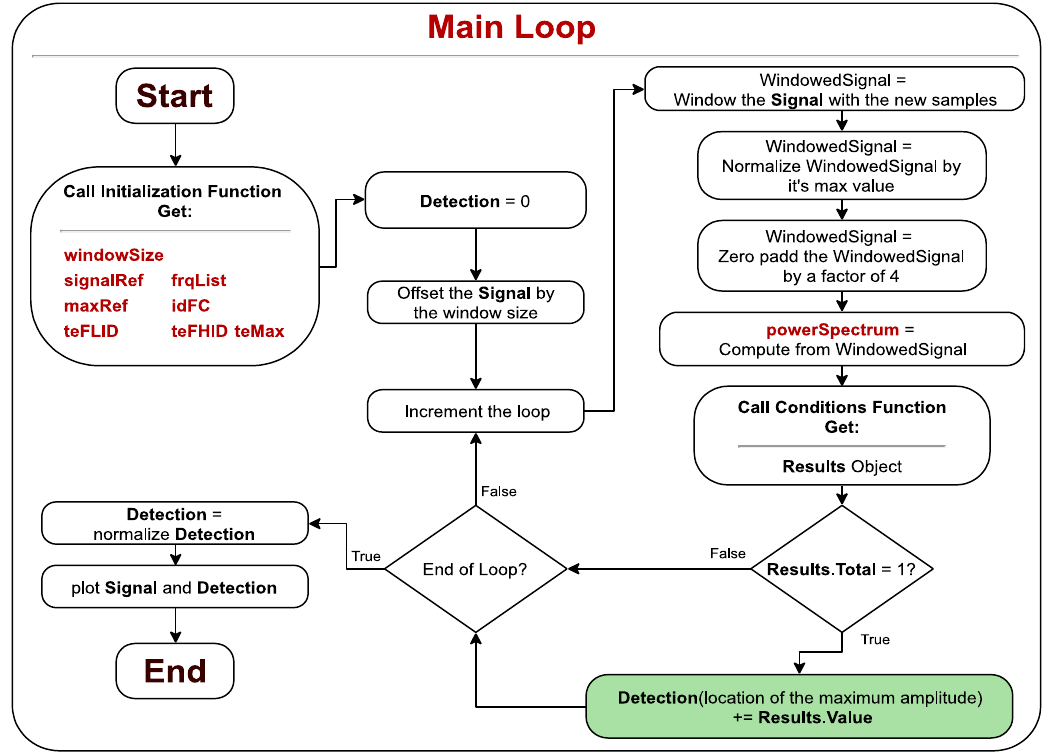
Figure 4. Flowchart of the main loop.